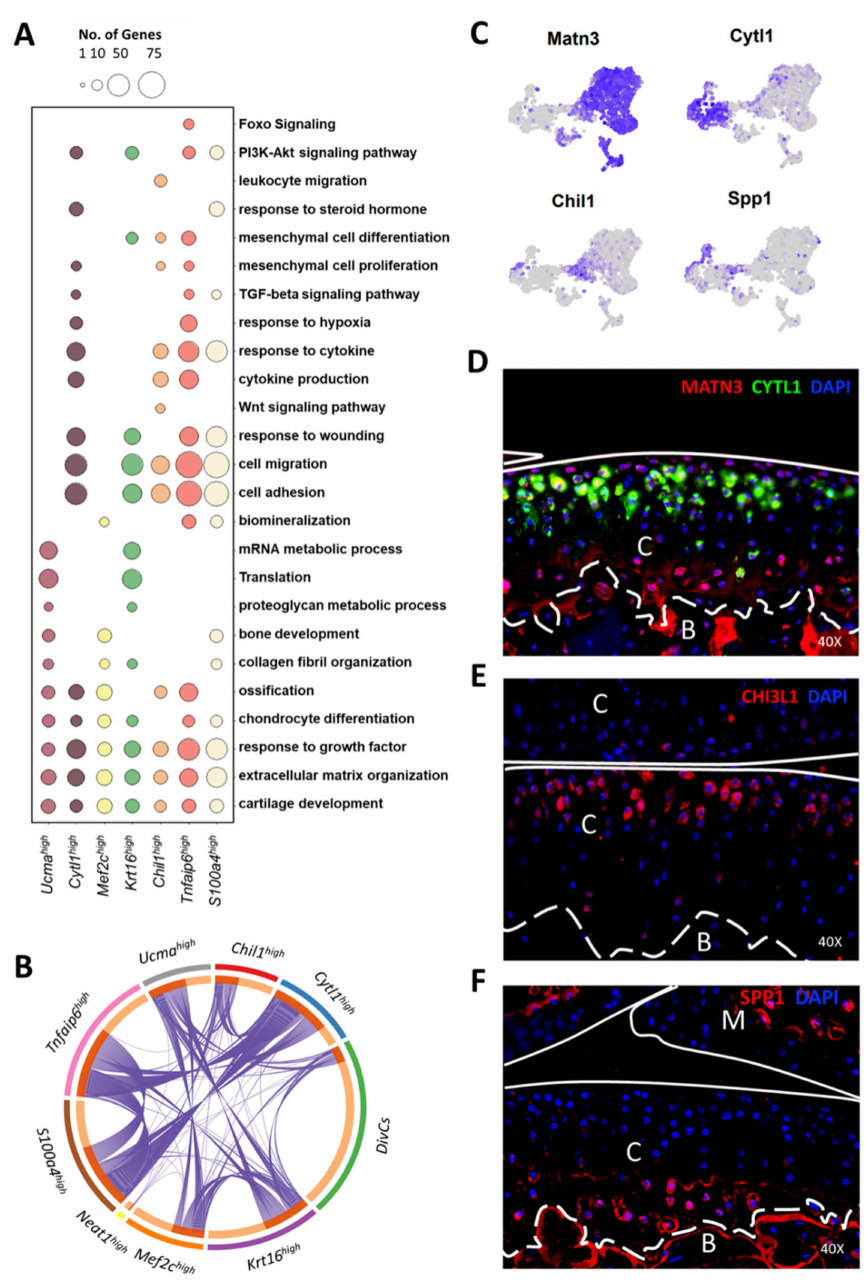
Figure 4. Functional characterization of chondrocyte subtypes. ( A ) Enriched ontologies for each chondrocyte subtype. Circle size indicates the number of genes associated with each category. ( B ) Circos plot showing overlap between genes enriched (>1.25-fold) in each cluster compared to all other clusters. The purple curves link identical genes. ( C ) Feature plots showing the expression of Matn3 , Cytl1 , Spp1 , and Chil1 . ( D ) Protein-level expression of Matn3 (red) and Cytl1 (green). ( E ) Protein-level expression of Chil1/CHI3L1 (red). ( F ) Protein-level expression of Spp1 (red). DAPI (blue); C: cartilage; B: bone; M: